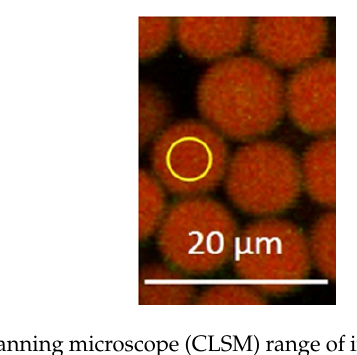
Figure 1. Confocal laser scanning microscope (CLSM) range of interest (ROI) circle inside of fluorescent melamine formaldehyde (MF) particles. Amplification 140×.